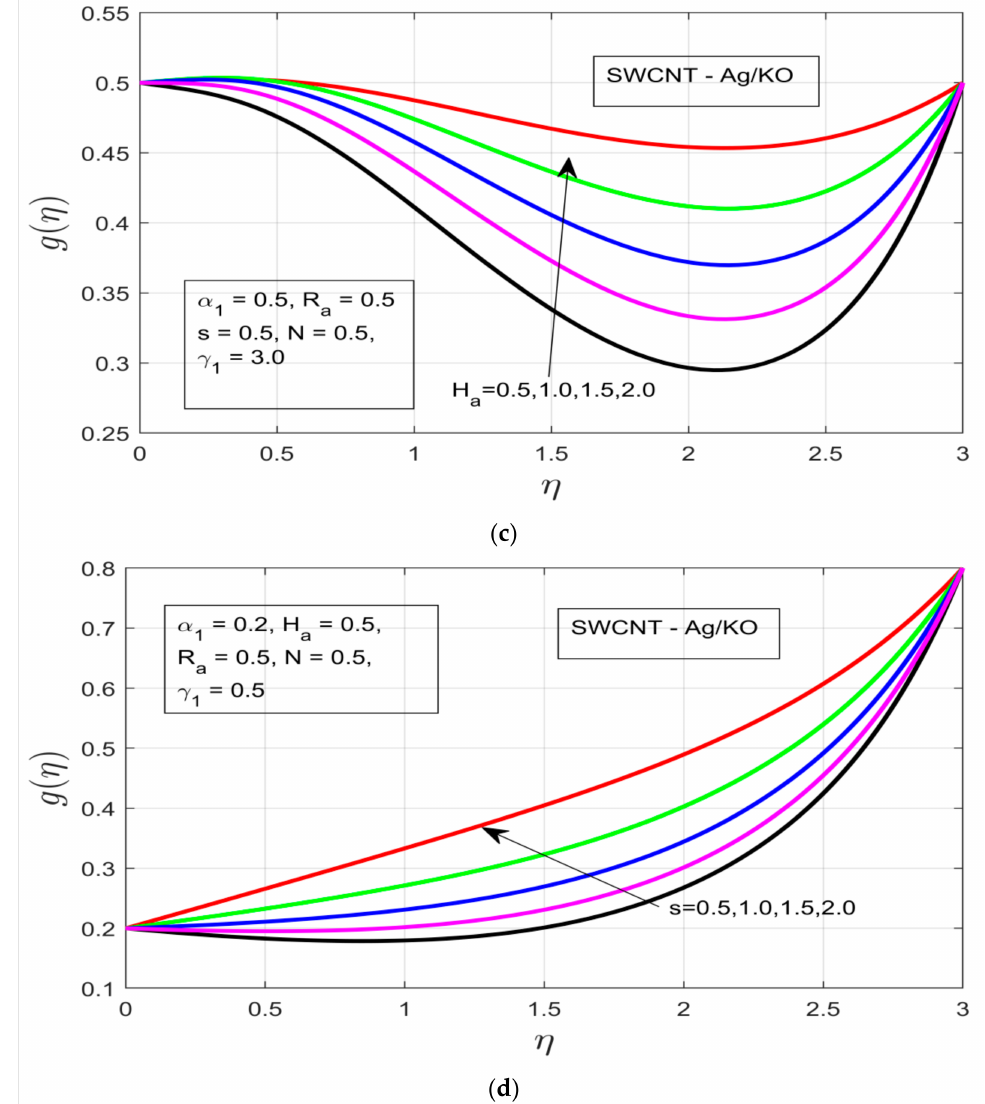
Figure 3. ( a ) Impact of the rotational ratio α 1 on g( η ) . ( b ) Outcome of the buoyancy parameter γ 1 on g( η ) . ( c ) Impact of the Hartman number H a on g( η ) . ( d ) Impact of the unsteadiness parameter s on g( η )